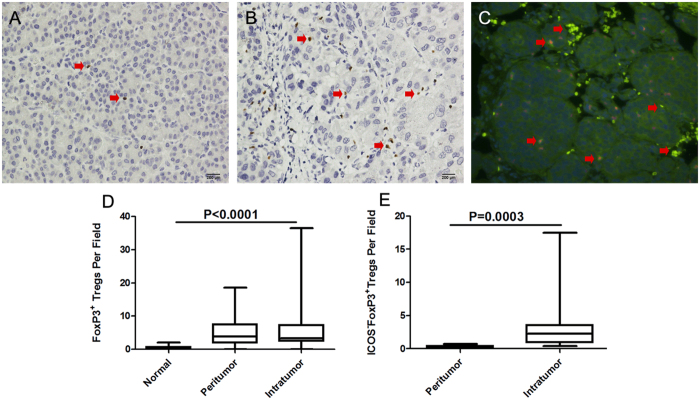
Increased numbers of FOXP3+ Tregs and ICOS+ FOXP3+ Tregs in intratumoral tissue.(A,B) Representative immunohistochemistry in normal tissues and intratumoral tissues, the FOXP3+ staining was confined to the nucleus (brown). (C) Representative double immunofluorescence in intratumoral tissues, the FOXP3+ staining was confined to the nucleus (red) and ICOS+ was on the cell surface (green). Sections were counterstained with DAPI. (D,E) FOXP3+ Tregs and ICOS+ FOXP3+ Tregs in intratumoral tissues were significantly higher. FOXP3 = Forkhead/Winged Helix Transcription Factor P3; Tregs = regulatory T cells; ICOS = inducible costimulator.